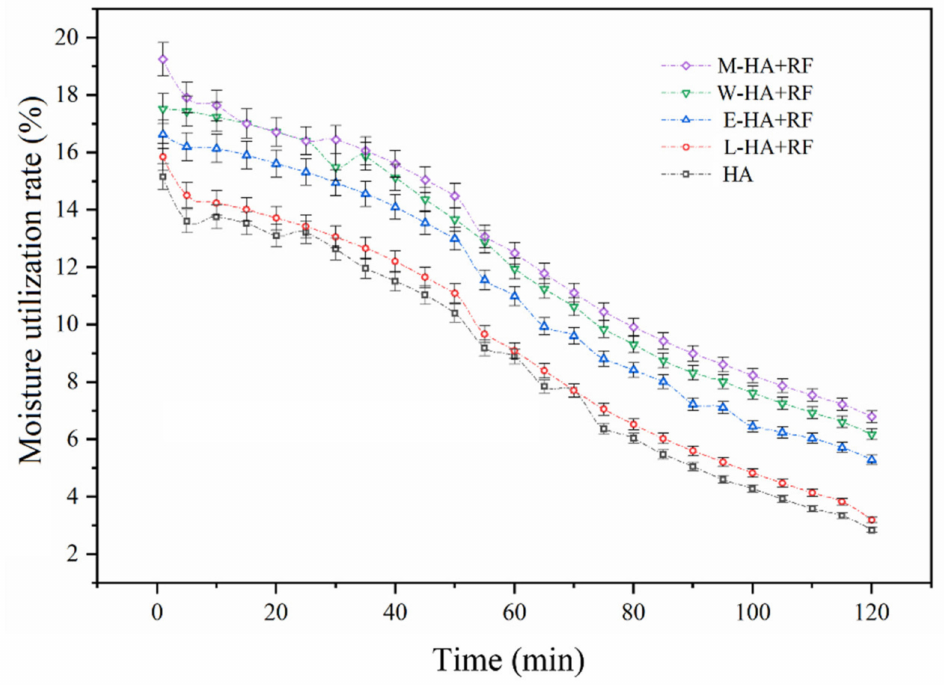
Figure 8. Moisture absorption rate of five groups of dried